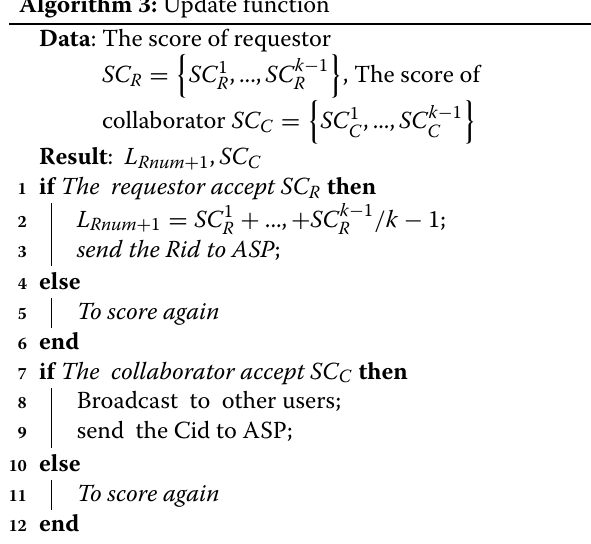
Algorithm 3: Update function